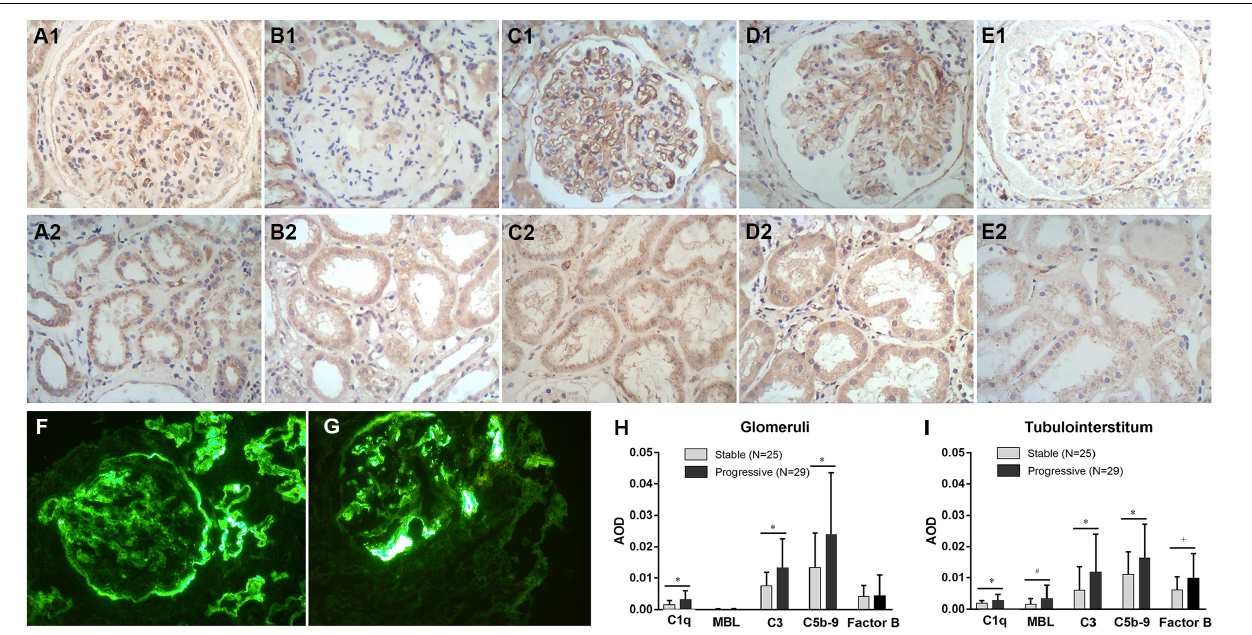
FIGURE 5 | Immunohistochemical staining for C1q (A1,A2) , MBL (B1,B2) , C3 (C1,C2) , C5b-9 (D1,D2) , and factor B (E1,E2) expression in kidney tissues, the expression level of C1q, MBL, C3, C5b-9, and factor B in the stable and progressive groups (H,I) , and direct immunofluorescence microscopy for C3 (F) or C1q (G) deposits in kidney tissues. MBL, mannose-binding lectin; AOD, average optical density. ∗ p < 0.05 versus stable group; # p = 0.057 versus the stable group; † p = 0.09 versus the stable